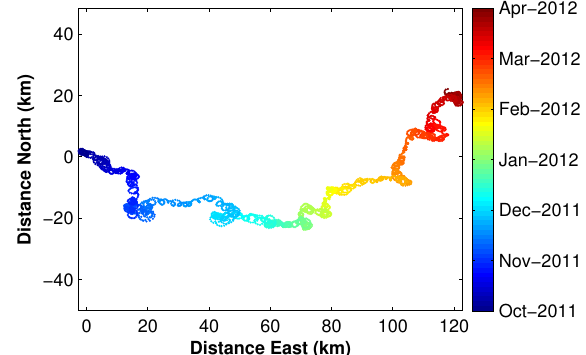
Figure 5. Power spectrum of the spectral analysis of (a) depth time series and (b) potential density anomaly time series. Pure red noise (null hypothesis) is represented by red dashed lines for each vari- able. The period corresponding to a significant power peak (power peak higher than the red noise) is written.